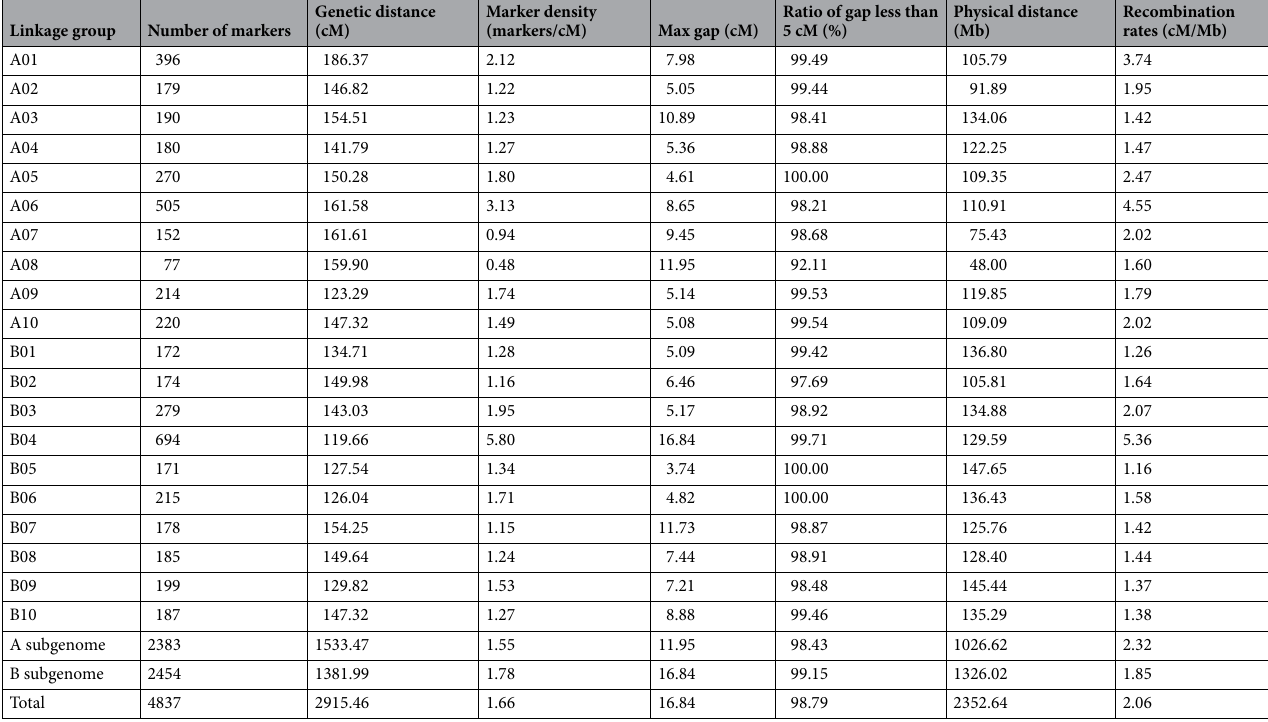
Table 1. Number of molecular markers, genetic distance, marker density, max gap, ratio of gap < 5 cM, physical distance and recombination rates in each linkage group of the peanut F 6 genetic linkage map.